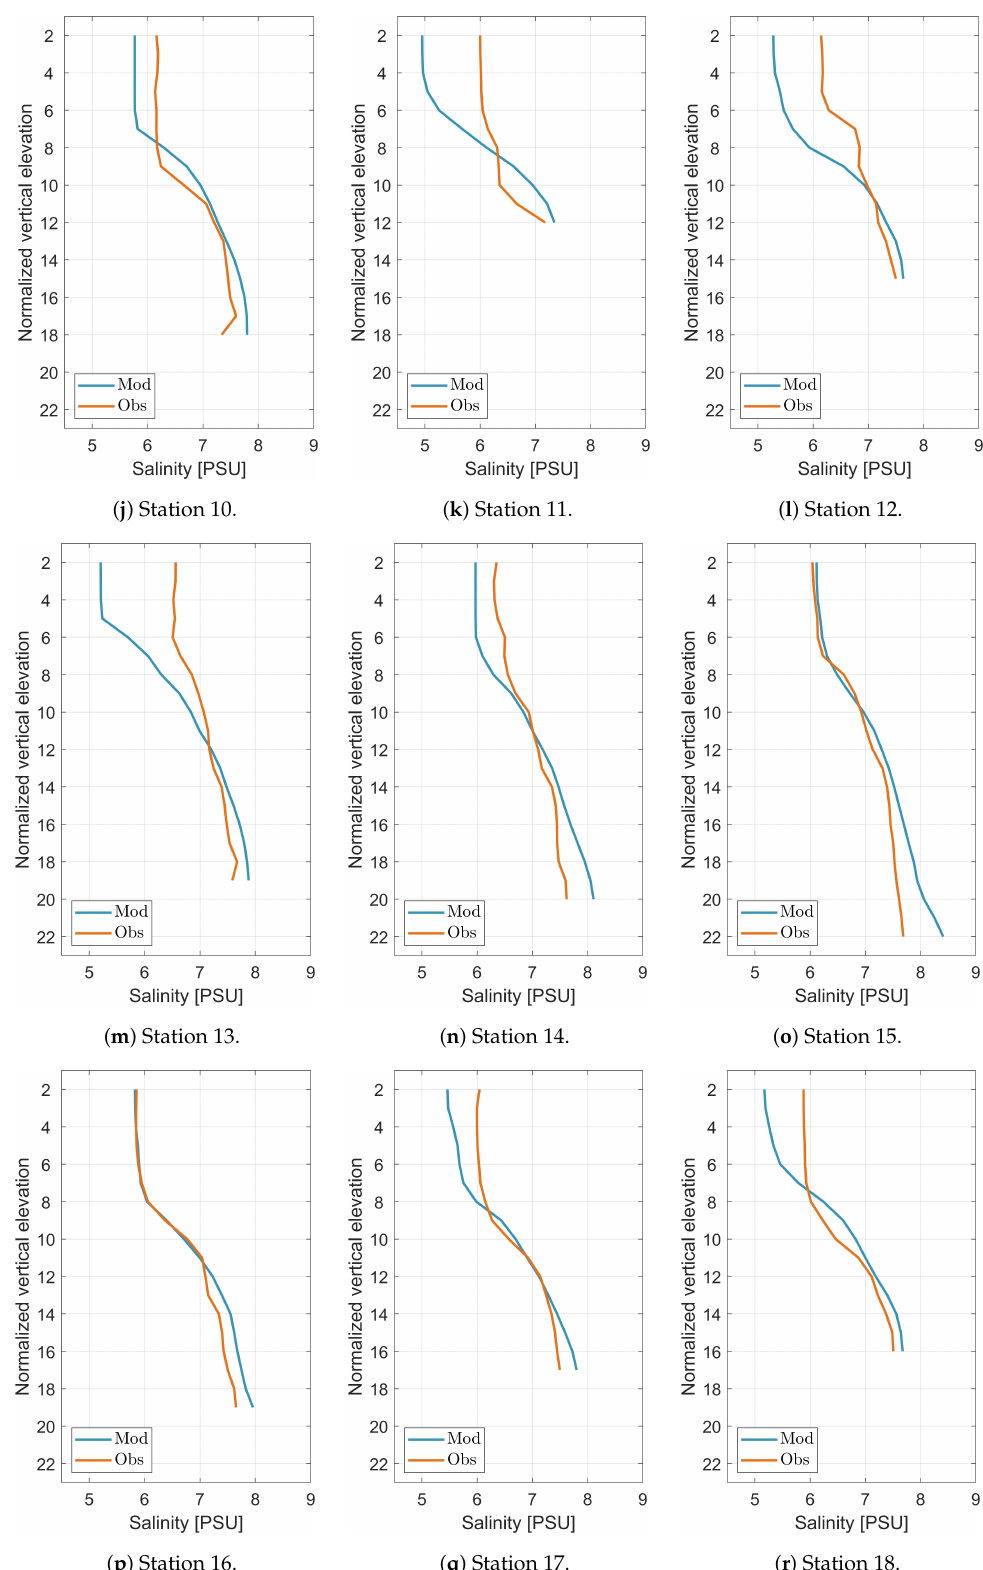
Figure A16. Salinity vertical profiles for all stations compared with s/y Oceania